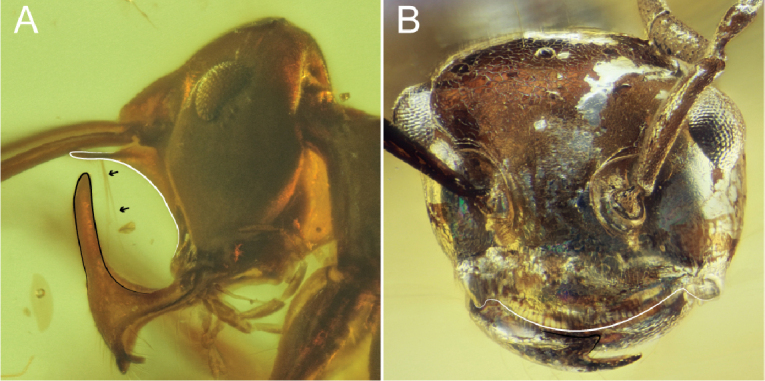
Cranium and mandibles of stem FormicidaeA †Linguamyrmex
brevicornis, worker, lateral view (FANTWEB00035, AntWeb: Vincent Perrichot) B †Gerontoformica species, worker, dorsolateral oblique (ANTWEB1032639).